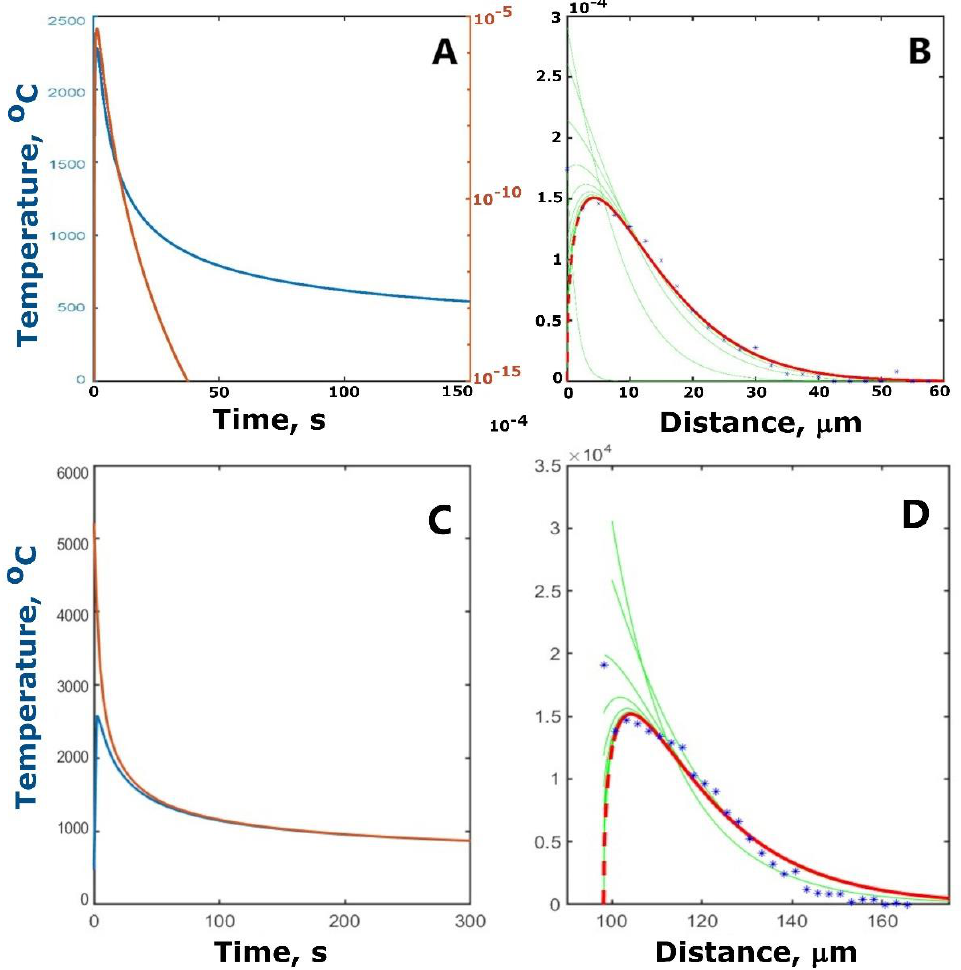
Figure 12. Time-temperature history of a zircon grain imaged in Figure 11F – L. ( A , B ) Calculation made for an averaged profile; ( C , D ) calculation for the “long” profile, see text for detail. Note markedly longer time and distance axis in ( C , D ) in comparison with ( A , B ). In ( A ) and ( C ): blue curves — best-fit temperature history for zircon dissolution; orange — corresponding variation of Zr diffusion coefficient. In ( B ) and ( D ) measured (stars) and simulated profiles of Zr concentration around the dissolving crystal (green thin lines). Quenched profile is shown by a red line.